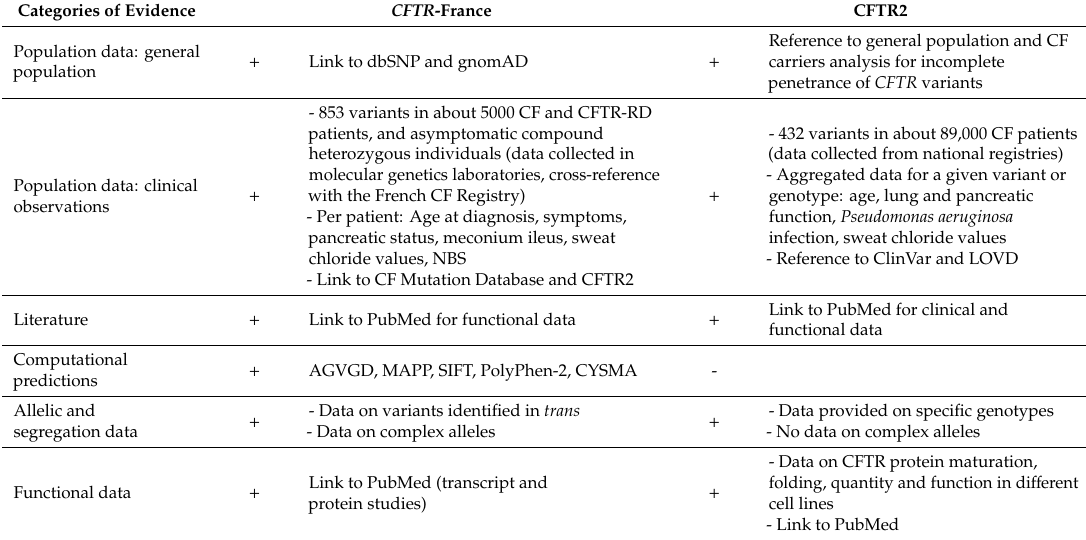
Figure 2. Links between health care professionals for carrying out appropriate CFTR studies and accurate interpretation of CFTR genetic test results. NPD: nasal potential difference; ICM: intestinal chloride measurement; SCT: sweat chloride testing. Table 1. Data available in CFTR -France and CFTR2 according to categories of evidence of variant